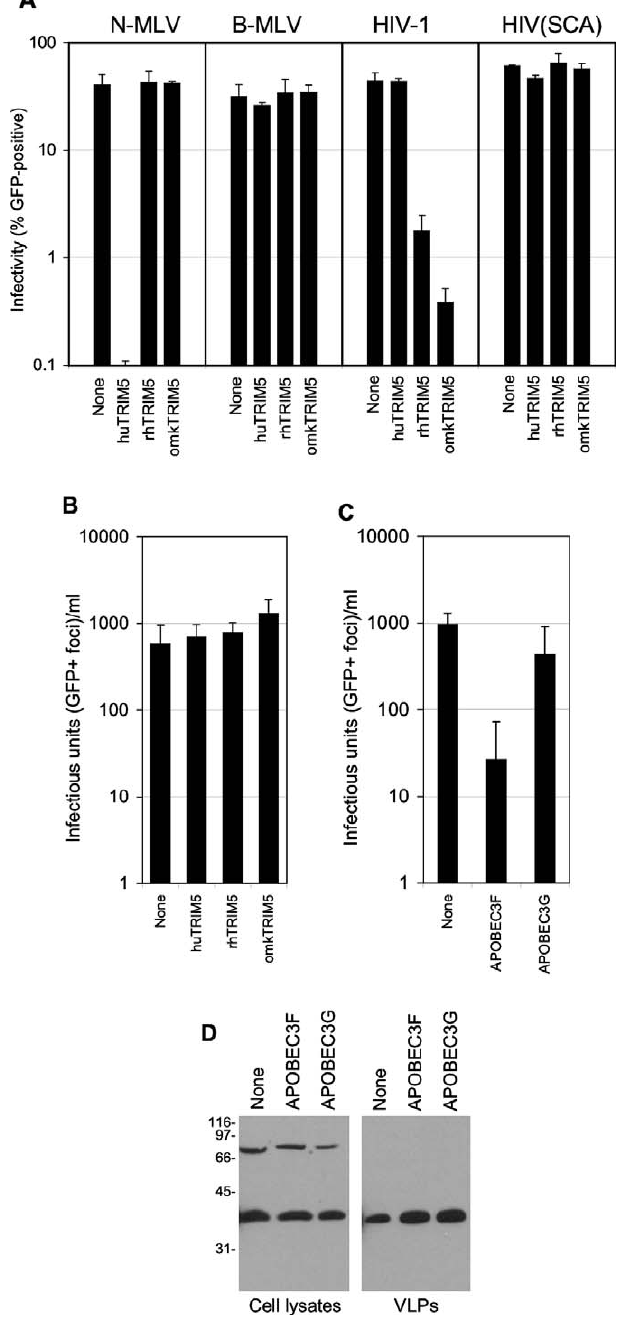
Figure 6. Effects of TRIM5 and APOBEC3 Proteins on HERV-K CON Infectivity (A) Unmanipulated CHO cells or variants stably expressing human TRIM5 a , rhesus monkey TRIM5 a , or owl monkey TRIM-Cyp were infected with VSV-G pseudotyped retroviral vectors that are sensitive to one or more of the TRIM5 proteins (N-MLV or HIV-1) or TRIM5-resistant controls (B-MLV or HIV-1 carrying SIVmac CA HIV(SCA)), as indicated. Two days postinfection, the percentage of GFP þ cells was determined using FACS. (B) The same panel of CHO-derived TRIM5-expressing CHO cell lines were inoculated with HERV-K CON (VSV-G). Two days postinfection, GFP þ foci were quantified. (C) APOBEC3F and APOBEC3G expression plasmids were cotransfected into 293T cells during generation of CHKCG-containing HERV-K CON (VSV- G) particles. Fresh 293T cells were infected with the resulting viral supernatant, and GFP þ foci were quantified 2 d later. (D) Western blot analysis, using the anti–HERV-K Gag antibody, of